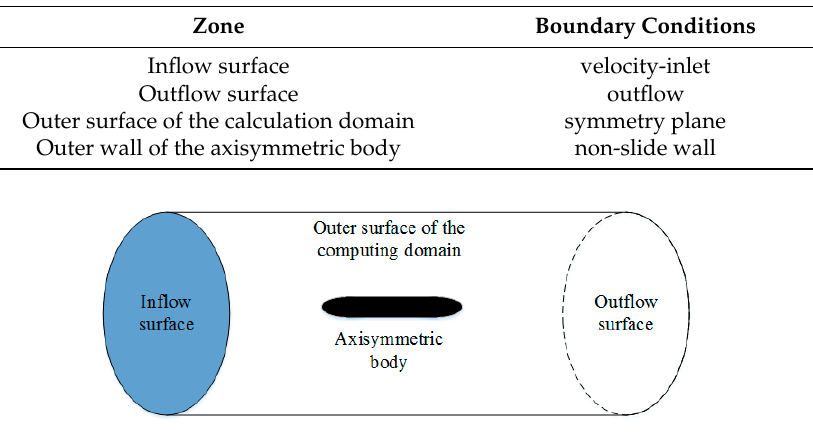
Figure 5. Computing domain. Table 1. Boundary conditions of numerical calculation.